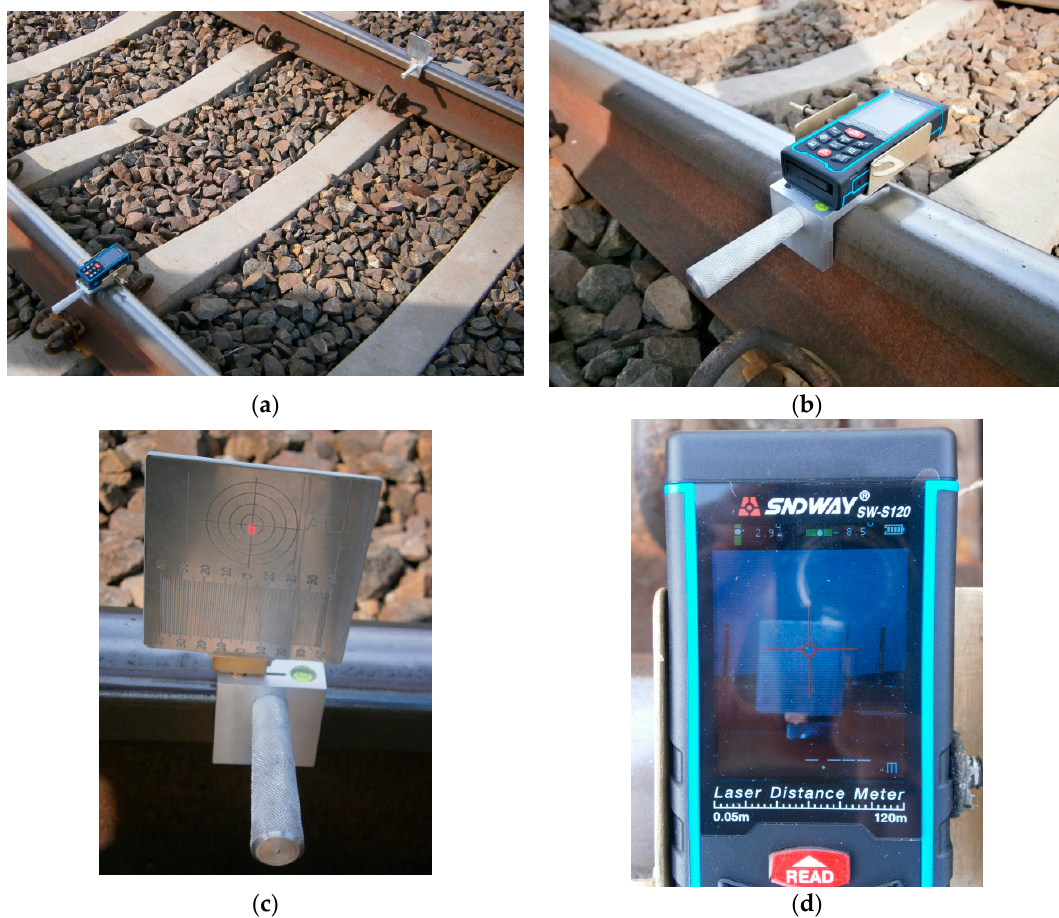
Figure 5. The Magnetic-Measuring Square (MMS) for measurements verifying the perpendicularity of the rail joints and shortening positions (own photograph): ( a ) the MMS location within rails; ( b ) the measuring square with a cap of the laser distance measuring device and with the laser distance measuring device; ( c ) the measuring square with a horizontal surveying measuring disk (with a millimeter scale with concentric rings); ( d ) the measuring square with a cap of the laser distance measuring device and with the laser distance measuring device with a visible surveying measuring disk, cross pointer, and video camera.